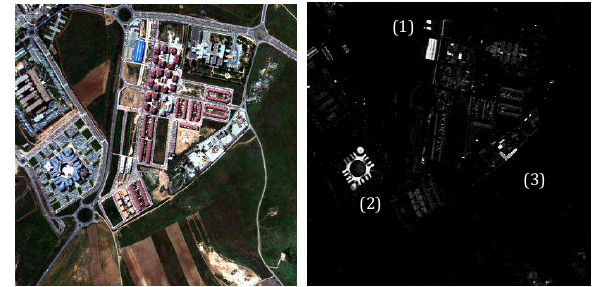
Figure 8. Anomaly detection detail for Alcalá de Henares test: AHS image true color combination (left) and DATB global (right) with three relevant results, (1) polyvinyl chloride, (2) zinc building cover and (3) asbestos building